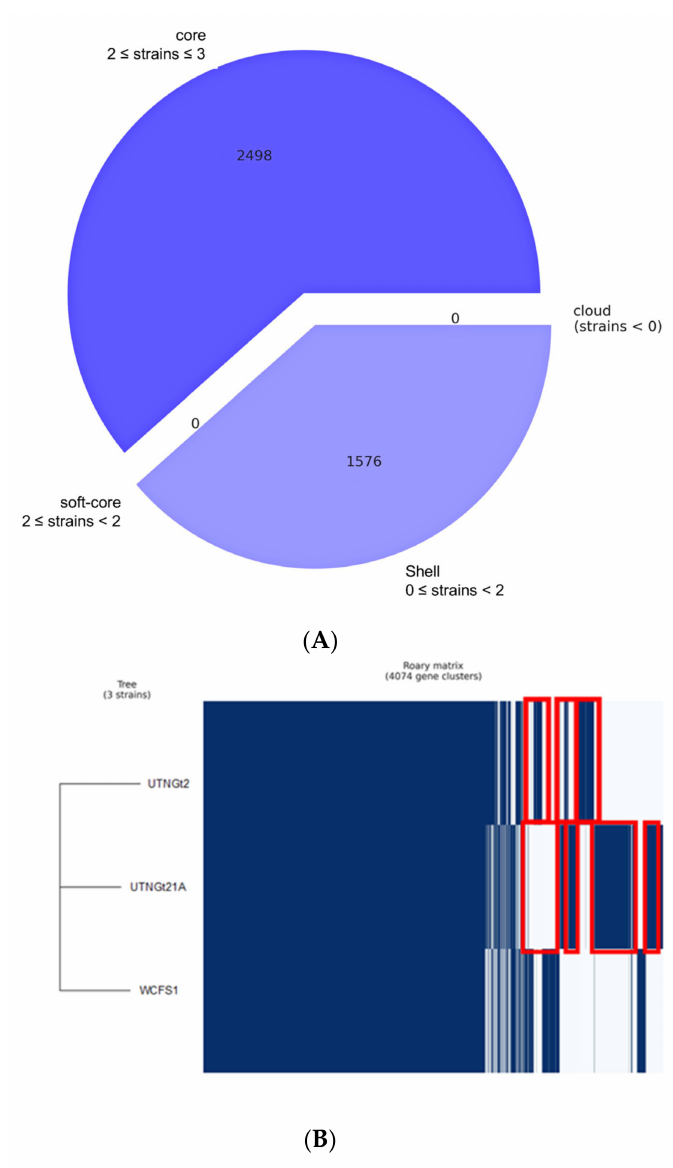
Figure 2. Gene content comparison of the three L. plantarum strains: ( A ) The pie chart shows the number of genes belonging to the core, the soft core, the shell, or the cloud. ( B ) The Roary matrix shows genes typical of each strain and those conserved in all strains. The red rectangular frame indicates several distinct cluster genes of the UTNGT21A and UTNGt2